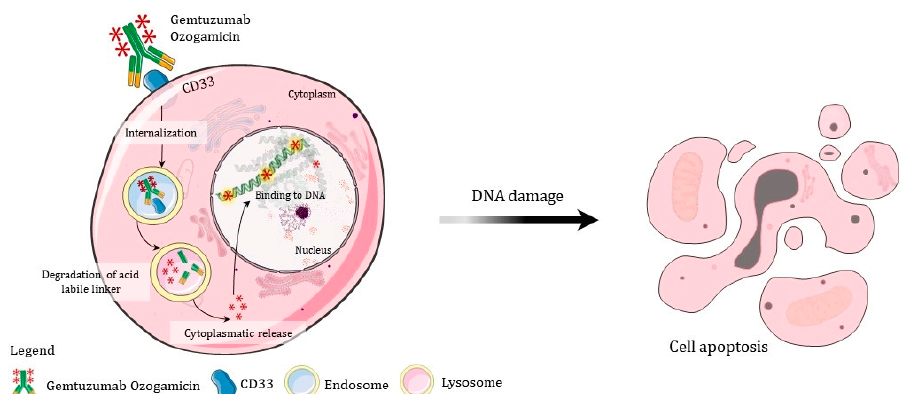
Figure 5. CD33-targeting Gemtuzumab-Ozogamicin. Once the CD33 receptor drives the molecules to endocytosis and degradation, the cytotoxic agent causes DNA damage and promotes cell death.